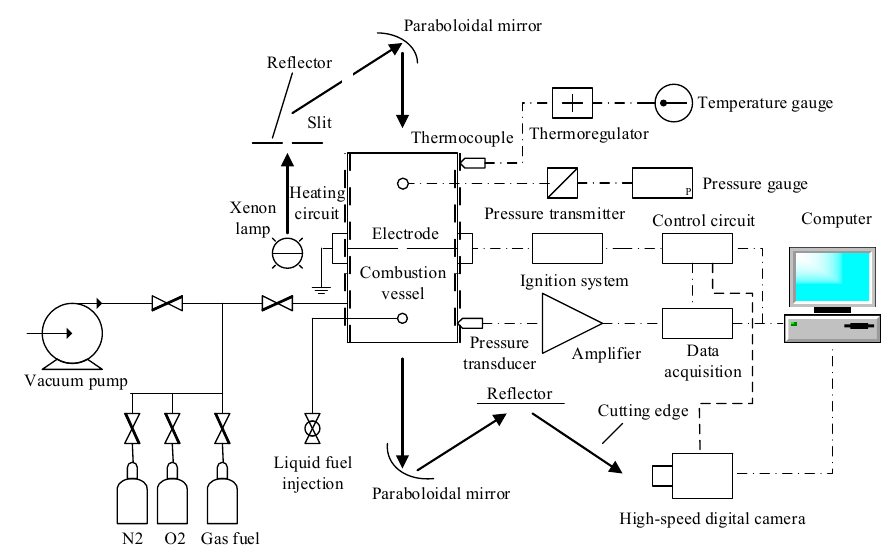
Figure 1. Schematic diagram of the experimental facility.